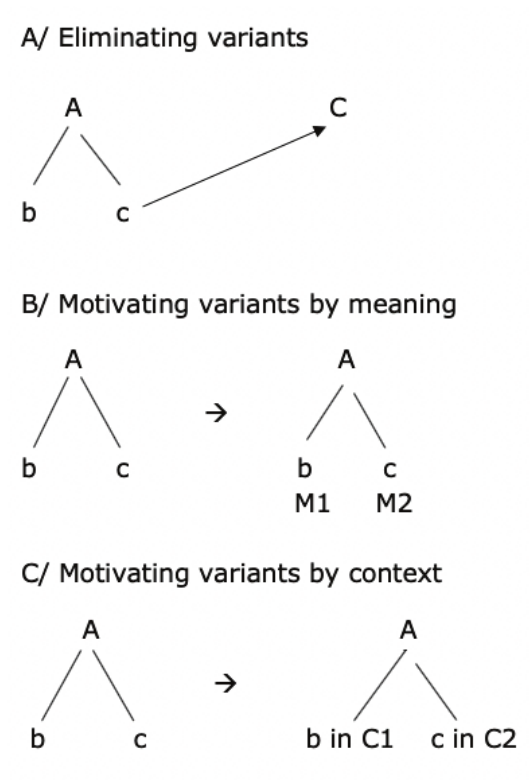
Figure 2: Accounts of